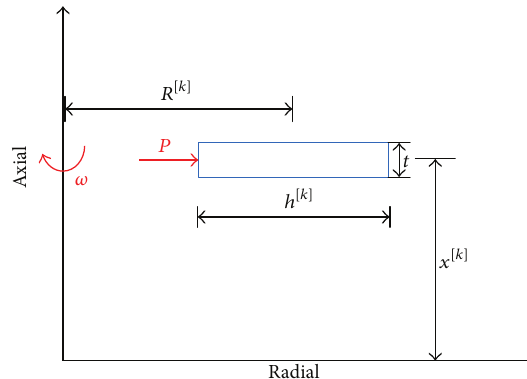
Figure 3: Geometry of an arbitrary disk